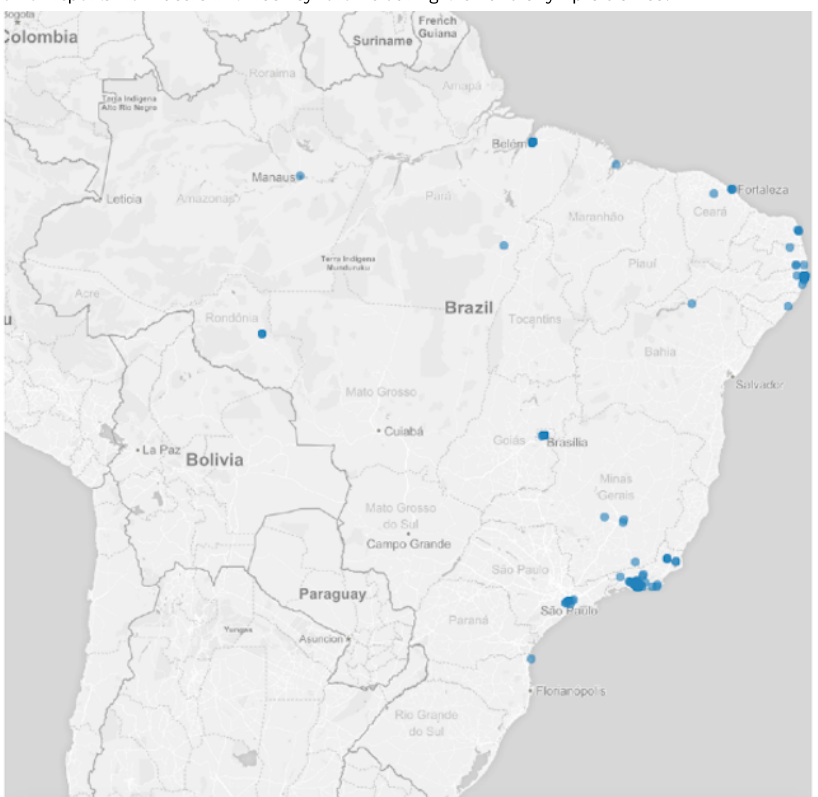
Figure 7. Spatial distribution of reports from users with rash syndrome during the 2016 Olympic